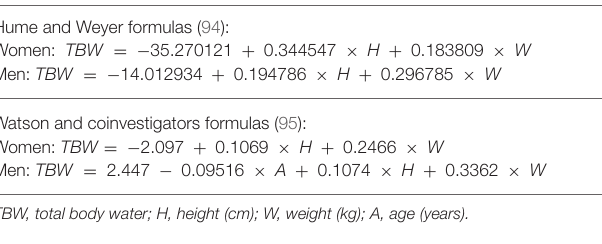
TABLE 1 | Anthropometric formulas estimating body water.